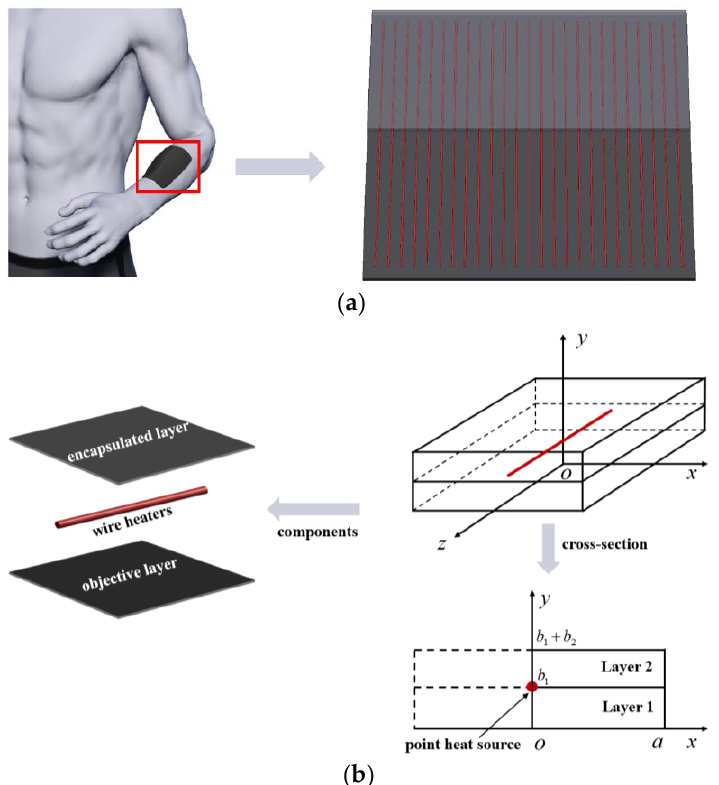
Figure 1. Schematic illustration of ( a ) a bi-layered FEH with parallel wire structures integrated with human skin and ( b ) a bi-layered transient heat conduction model.